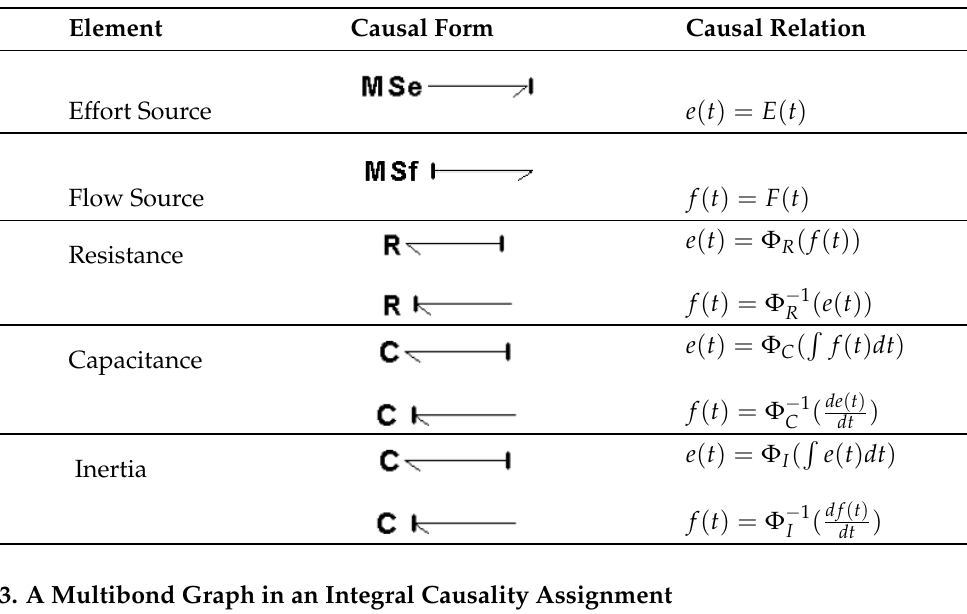
Table 2. Causal forms for one-ports.